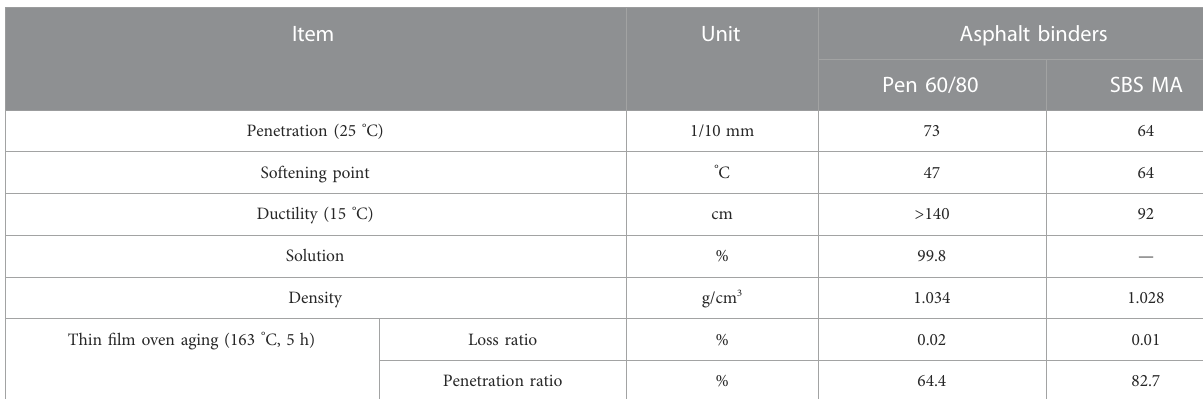
TABLE 1 Properties of binders.